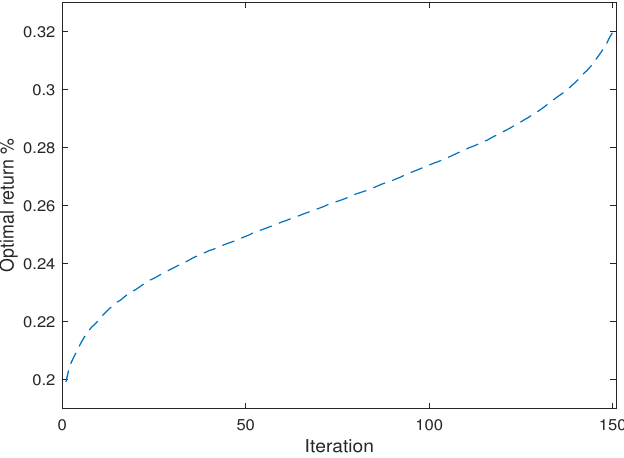
Figure 12. The return of optimal portfolio in different iterations in X ∈ [ − 0.05,0.15 ] of model (30).